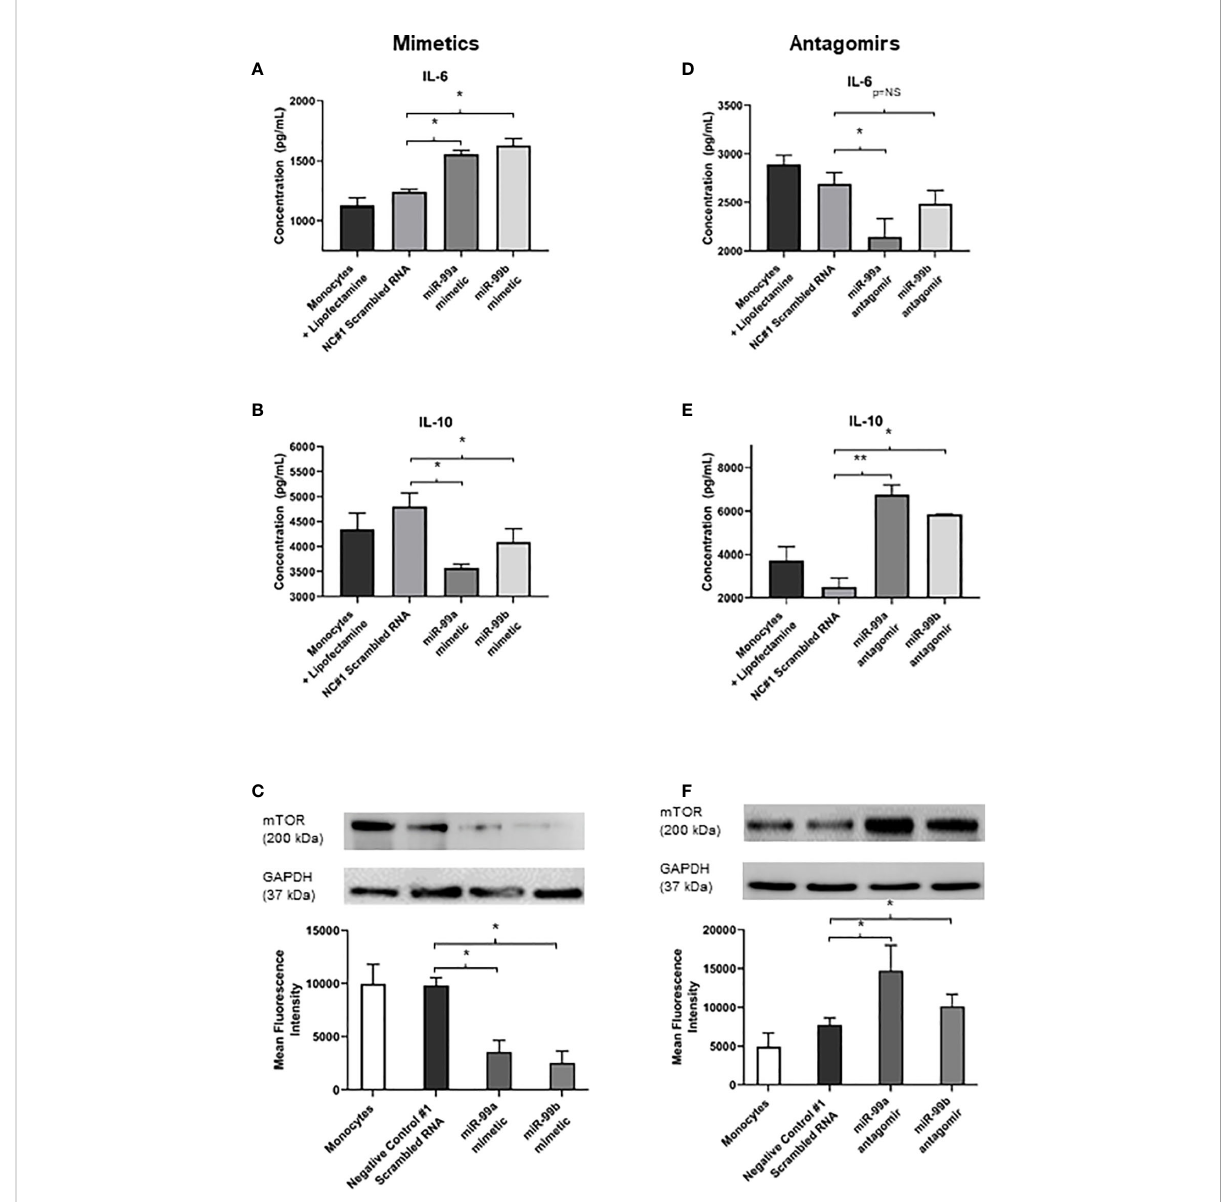
FIGURE 5 Exosomal miR-99a and miR-99b drives the proin fl ammatory response in monocytes by downregulating mTOR following S. aureus infection (A, B) IL-6 and IL-10 expression in monocytes treated with miR-99a/b mimetics following a 24 hour S. aureus infection was determined by ELISA. Monocytes treated with lipofectamine 3000, and negative control scrambled RNA were considered negative controls, where neither group showed signi fi cant differences in cytokine levels. Monocytes transfected with miR-99a and miR-99b mimetics resulted in a signi fi cant increase to IL-6 levels, which also observed a signi fi cant decrease in IL-10 expression. (C) Total mTOR expression in monocytes treated with miR-99a/b mimetics in the presence of a 24 hour S. aureus infection was determined by western blot and densitometry analyses. GAPDH was used as a loading control. Transfection of either the miR-99a or miR-99b mimetic caused a signi fi cant reduction in mTOR production. (D, E) MiR-99a and miR-99b antagomirs were transfected into monocytes in the presence of S. aureus infection. IL-6 and IL-10 levels were assessed using ELISA. miR-99a antagomirs resulted in signi fi cant decrease to IL-6 production yet miR-99b antagomirs maintained IL-6 at physiological levels compared to negative controls. (D) Knockdown of miR-99a and miR-99b using antagomirs resulted in a signi fi cant increase in IL-10 production relative to negative control scrambled RNA. (E) , (F) Total mTOR expression of monocytes treated with miR-99a/b antagomirs following a 24 hour S. aureus infection was determined by western blot and densitometry analyses. Both antagomirs resulted in a signi fi cant increase in mTOR levels relative to the negative controls. Comparatively, IL-6 and IL-10 production directly correlated with the changes in mTOR activity. Data is represented as mean ± SEM (n=6 western blot; n=4 ELISA; *p<0.05). NC, Negative control. **P<0.01, NS, not signi fi